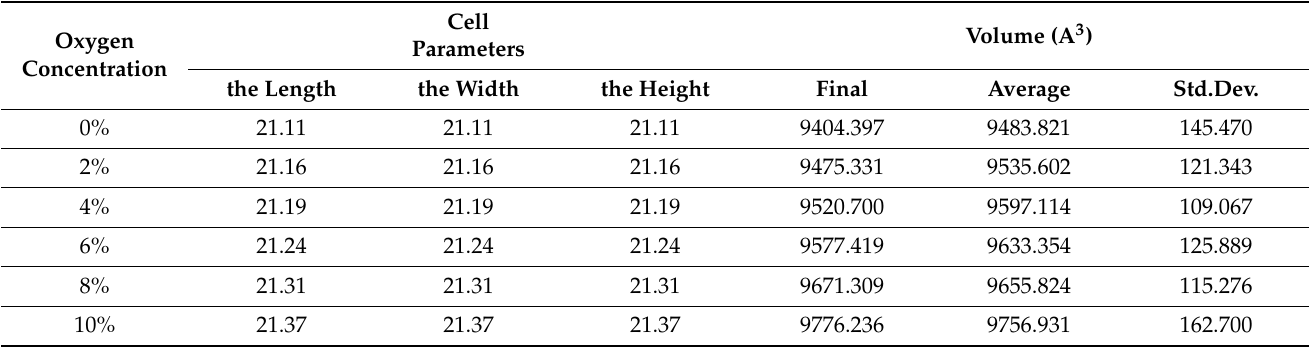
Table 3. Cell parameter and volume variation of the cellulose-water-oxygen system.